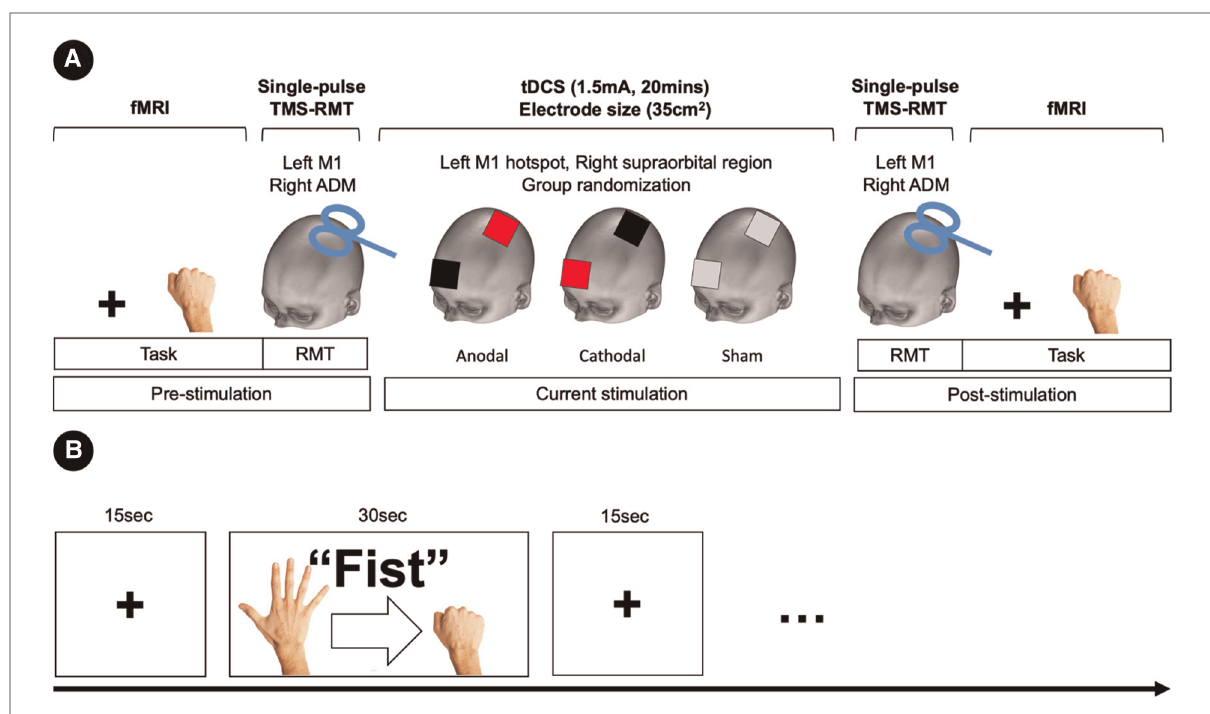
FIGURE 1 Experimental deign and procedures. ( A ) Task-fMRI and resting motor thresholds (RMTs) were assessed before and after tDCS stimulation (pre/post- stimulation). RMTs were elicited in the left primary motor cortex (M1) with single-pulse TMS of the abductor digiti minimi (ADM) muscle of the right hand. Subjects were assigned to a stimulus type in a randomized, counterbalanced design. Anodal stimulation is represented in red, cathodal stimulation in black, and sham in grey. ( B ) Block fMRI design for the hand motor